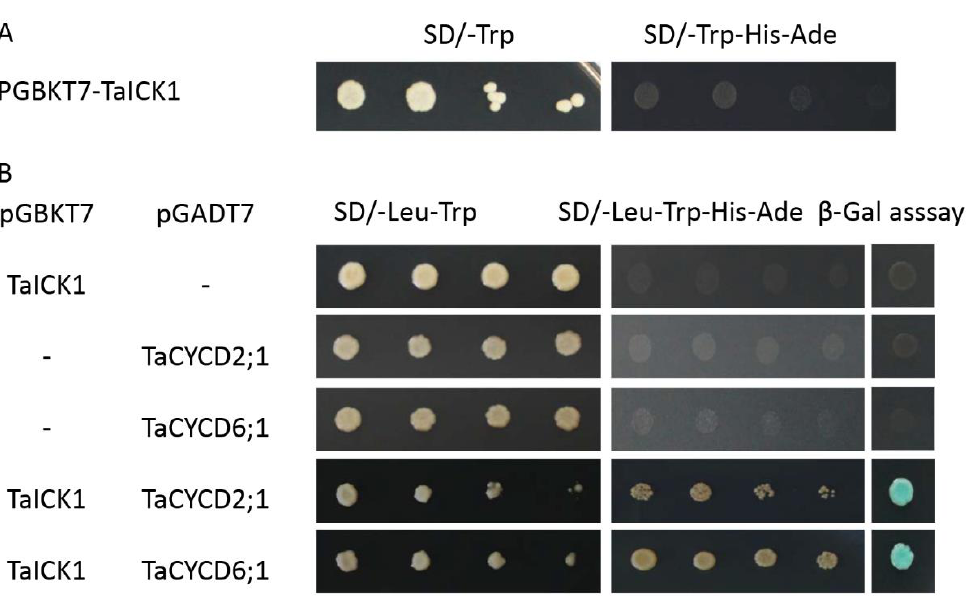
Figure 8. The interaction of TaICK1 with CYCD2;1 and CYCD6;1 in a yeast two-hybrid assay. ( A ) Transcriptional activation analysis of the TaICK1 in yeast. ( B ) The interaction of TaICK1 with TaCYCD2;1 and TaCYCD6;1 in the yeast two-hybrid assays.